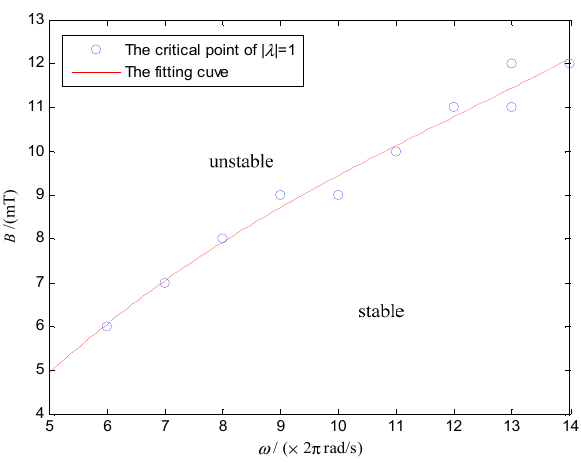
Figure 9. Asymptotically stable domain of the DSCR in the parameter space of ω and B .